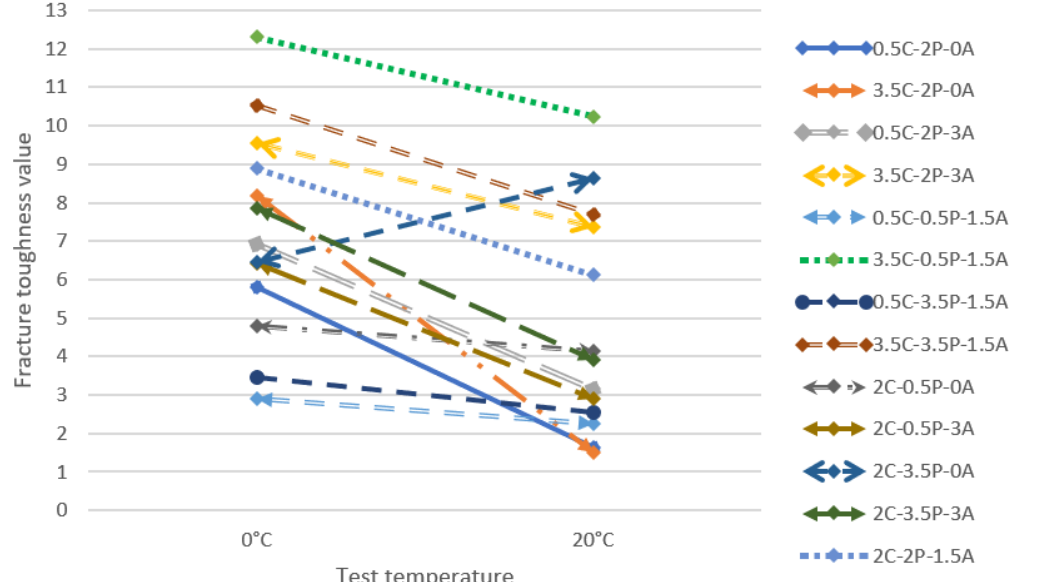
Figure 10. Plot of variation in fracture toughness K IC depending on the test temperature.